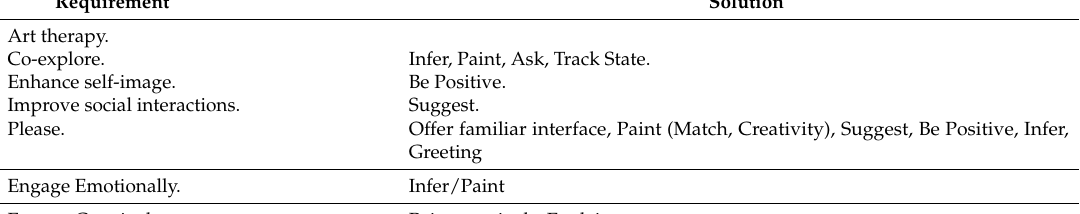
Table 2. Design for art therapy robot: relating requirements to capabilities. Requirement Solution Art therapy. Co-explore. Infer, Paint, Ask, Track State. Enhance